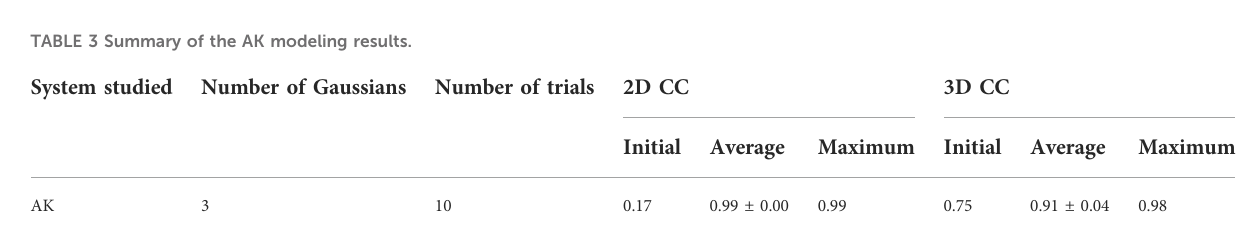
TABLE 3 Summary of the AK modeling